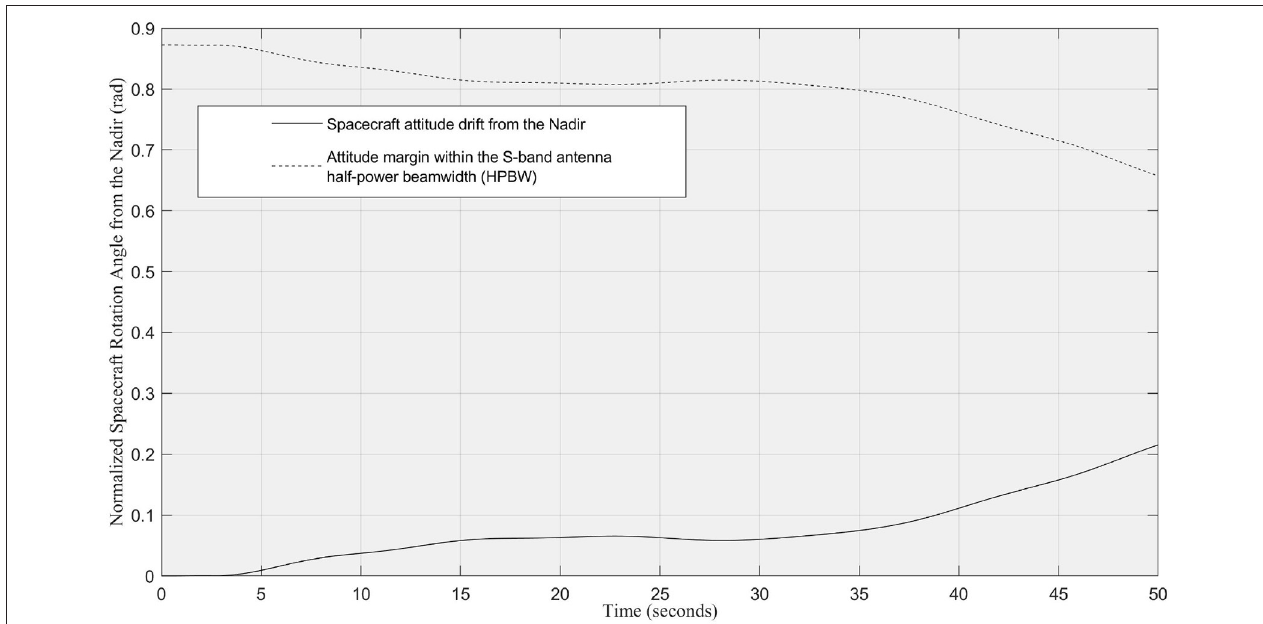
FIGURE 14 | The normalized attitude drift (in rads) of the free-floating spacecraft relative to the Nadir during the manipulator operation in the simulation. The attitude drift is within the S-band patch antenna half-power beamwidth (HPBW) for stable ground